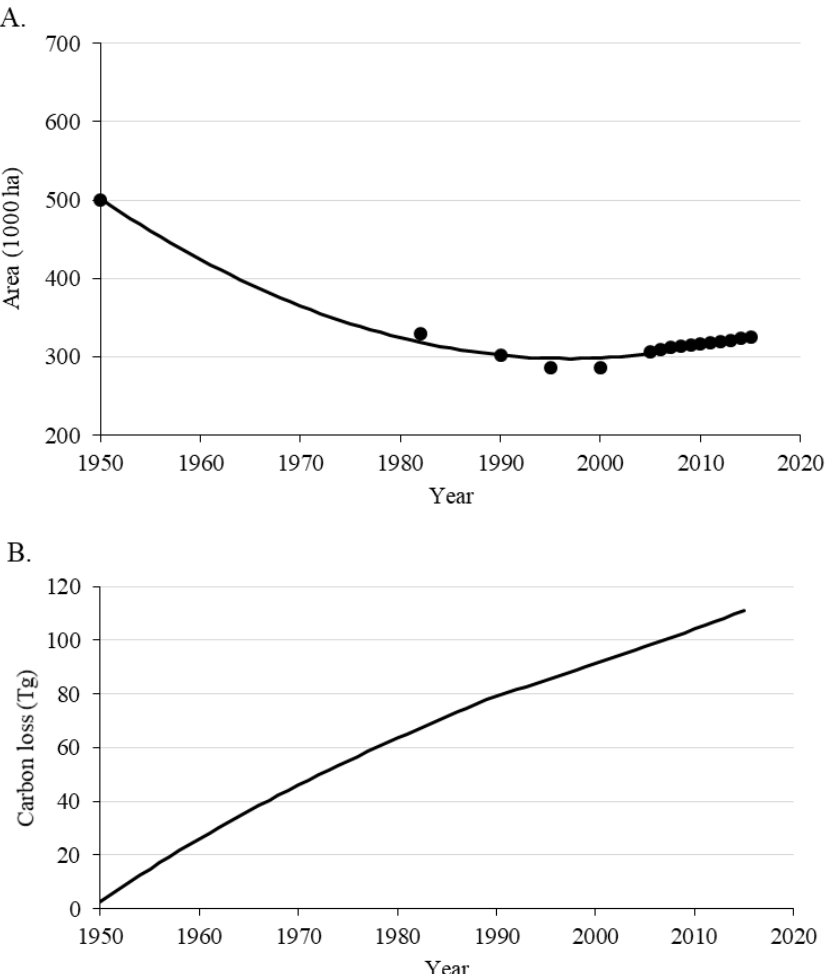
Figure 7. A) Development of cultivated agricultural peat soil area 1950–2015 in Finland (SVT 1954,